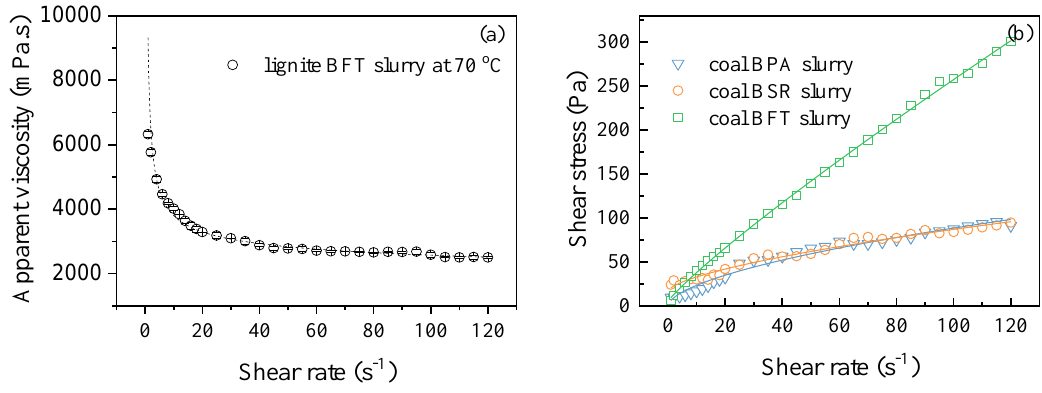
Figure 4. ( a ) Apparent viscosity of coal bio-oil derived from fruit trees pyrolysis (BFT) slurry (with concentration of 10%) as a function of the shear rate at 70 °C. ( b ) Shear stress of slurry fuels as a function of the shear rate.